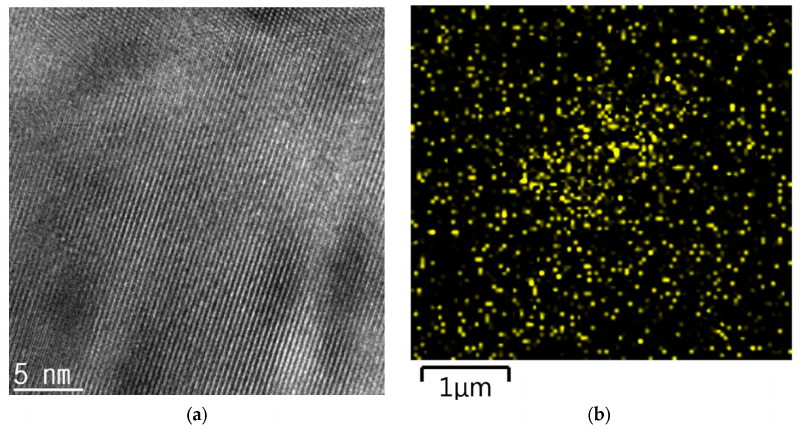
Figure 7. ( a ) TEM image of PVP/CuO/ p -BQ and ( b ) EDS analysis.